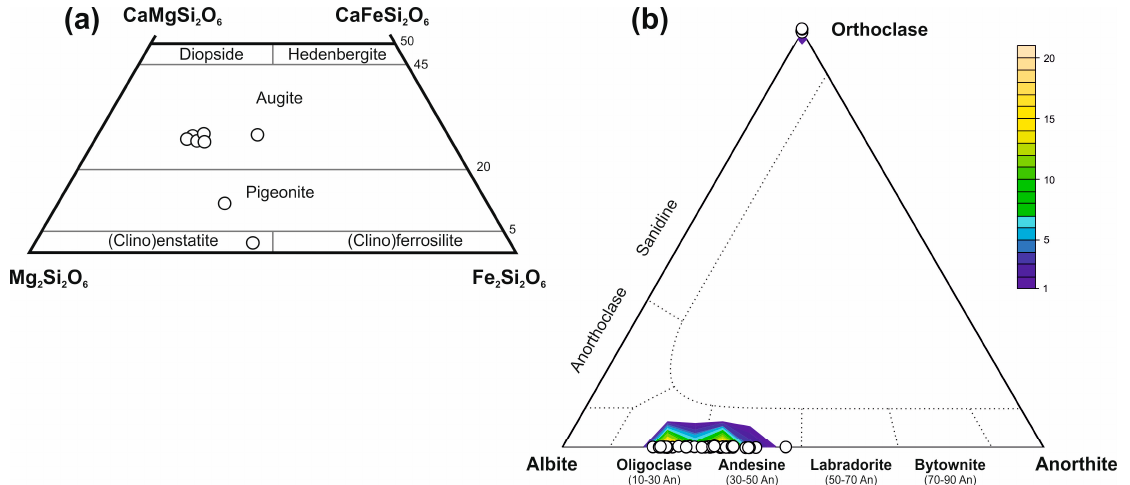
Figure 6. ( a ) pyroxene chemistry of the orthoamphibolites from the Aravalli area, plot of the EPMA data in the pyroxene classification diagram after [20], ( b ) plagioclase chemistry of the orthoamphibolites from the Aravalli area, plot of the EMPA data in the feldspar classification diagram.